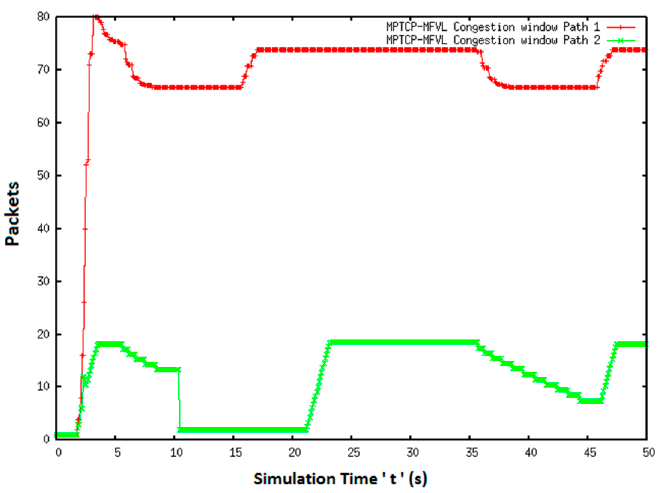
Figure 16. Congestion window plots of the proposed model MFVL HCCA (MPTCP-MFVL) for Setup